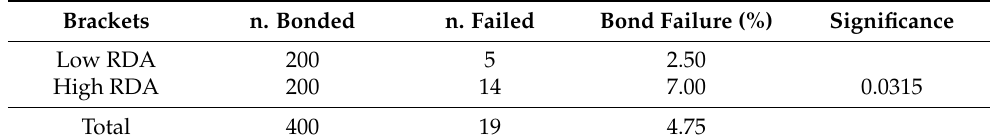
Table 6. Comparison of failure rates between low and high RDA values for the total amount of brackets